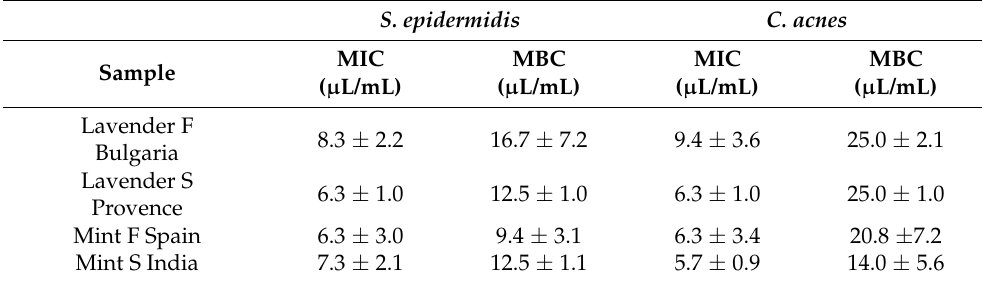
Table 5. MIC and MBC of lavender and mint